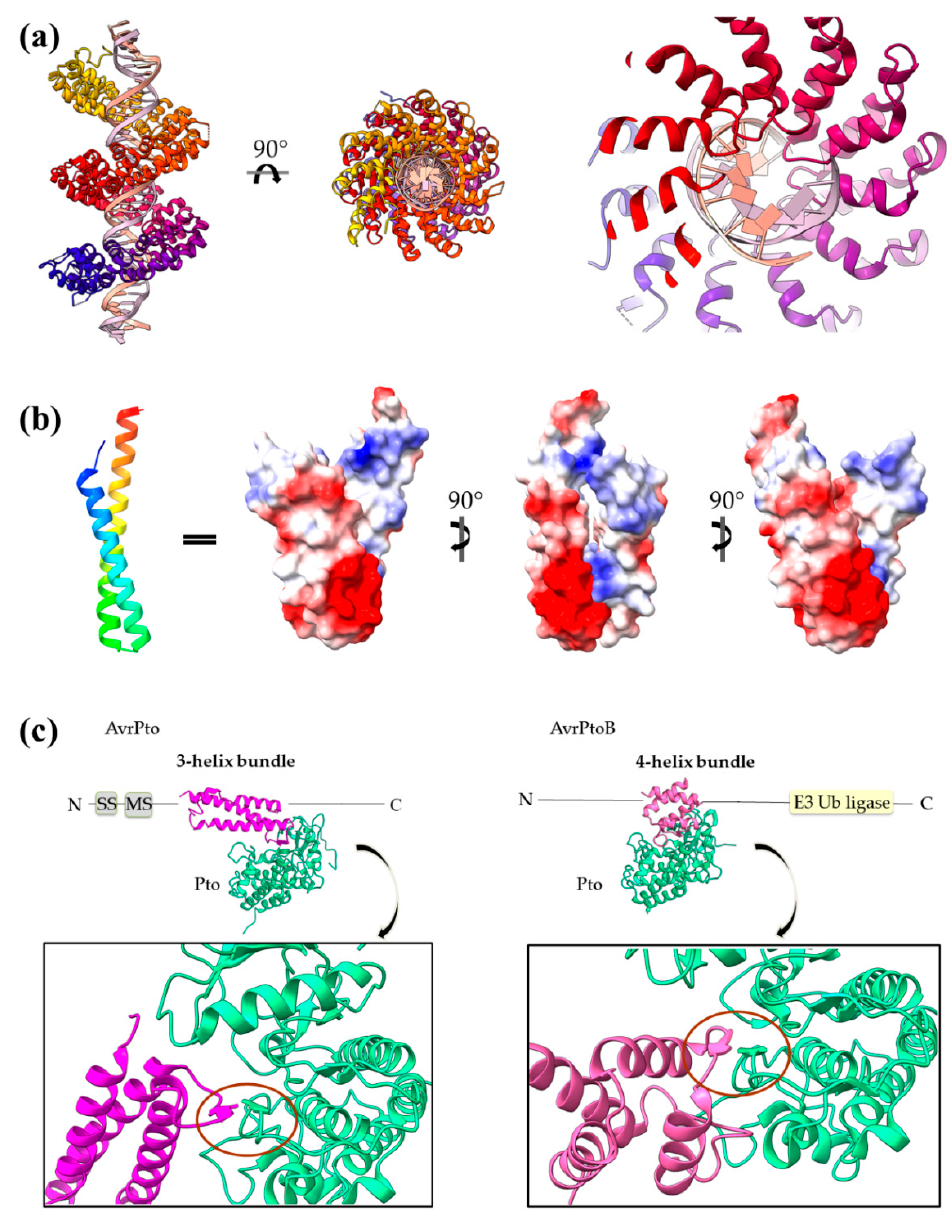
Figure 10. ( a ) PthXo1 protein in complex with DNA (PDB id 3UGM). The structure comprises tandem repeats of a helix–loop–helix motif. The protein is colored from N-terminus (blue) to C-terminus (red). DNA specific recognition and binding occurs through the hypervariable, in sequence, loop of the motif (right). ( b ) The AvrRps4 mature structure is a coiled coil with electrostatically diverse sides (PDB id 4B6X). Red and blue colors on the surface denote negative and positive charge, respectively. ( c ) Each of the AvrPto and AvrPtoB proteins (magenta) interact with the Pto host kinase (green). Left: schematic diagram of the AvrPto protein and close-up of the AvrPto–Pto interaction (PDB id 2QKW). Right: schematic diagram of the AvrPtoB protein and close-up of the AvrPtoB–Pto interaction (PDB id 3HGK).